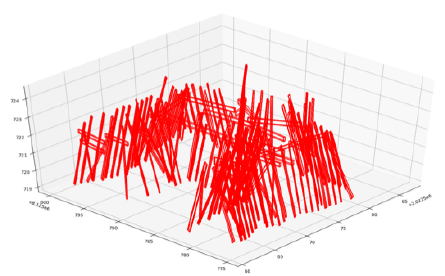
Figure 10. Beam geometry construction. The height parameter need to be processed